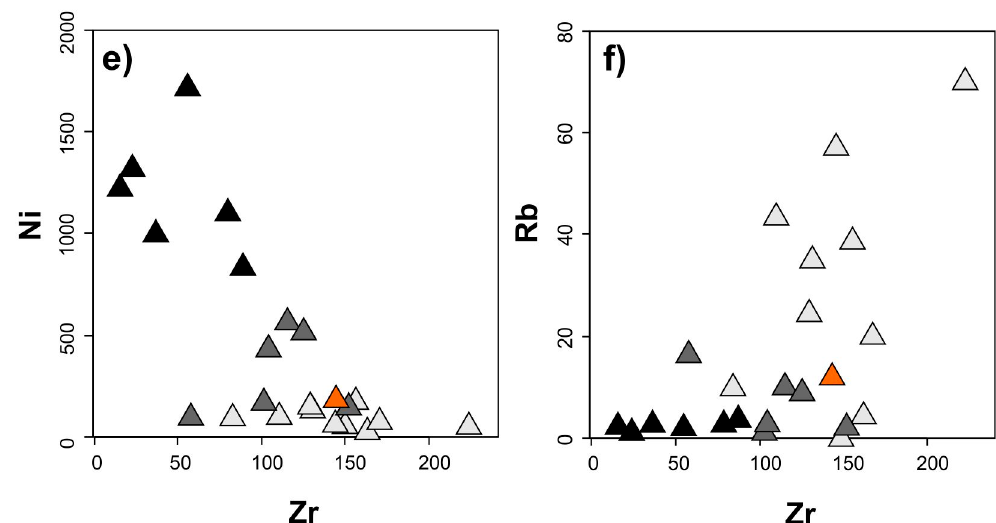
Figure 10. Bivariate plots of Zr (as an index of fractionation) versus selected elements for the AR-6C sample and Nathdwara rocks (data from [10]). ( a ) major oxide (MgO) vs. Zr, ( b – f ) trace elements (La, Nb, Y, Ni, Rb) vs.